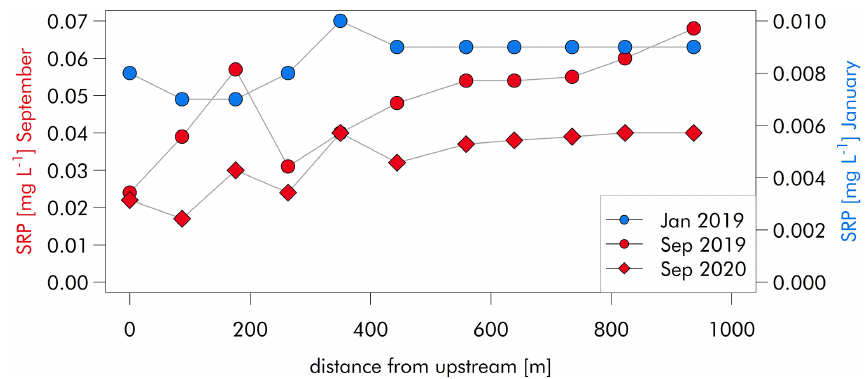
Figure 3. Longitudinal SRP concentration profiles for the three measurement campaigns in January 2019, September 2019, and September